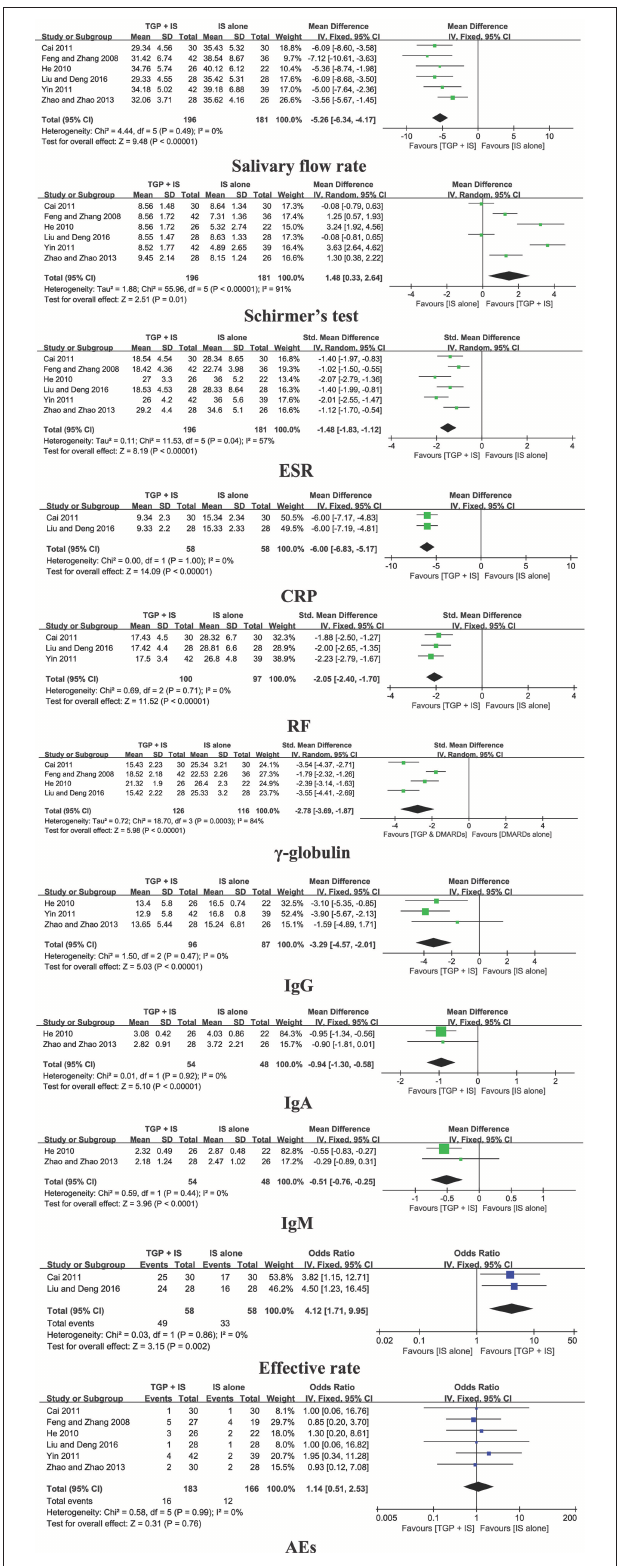
FIGURE 5 | Forest plots comparing TGP + IS and